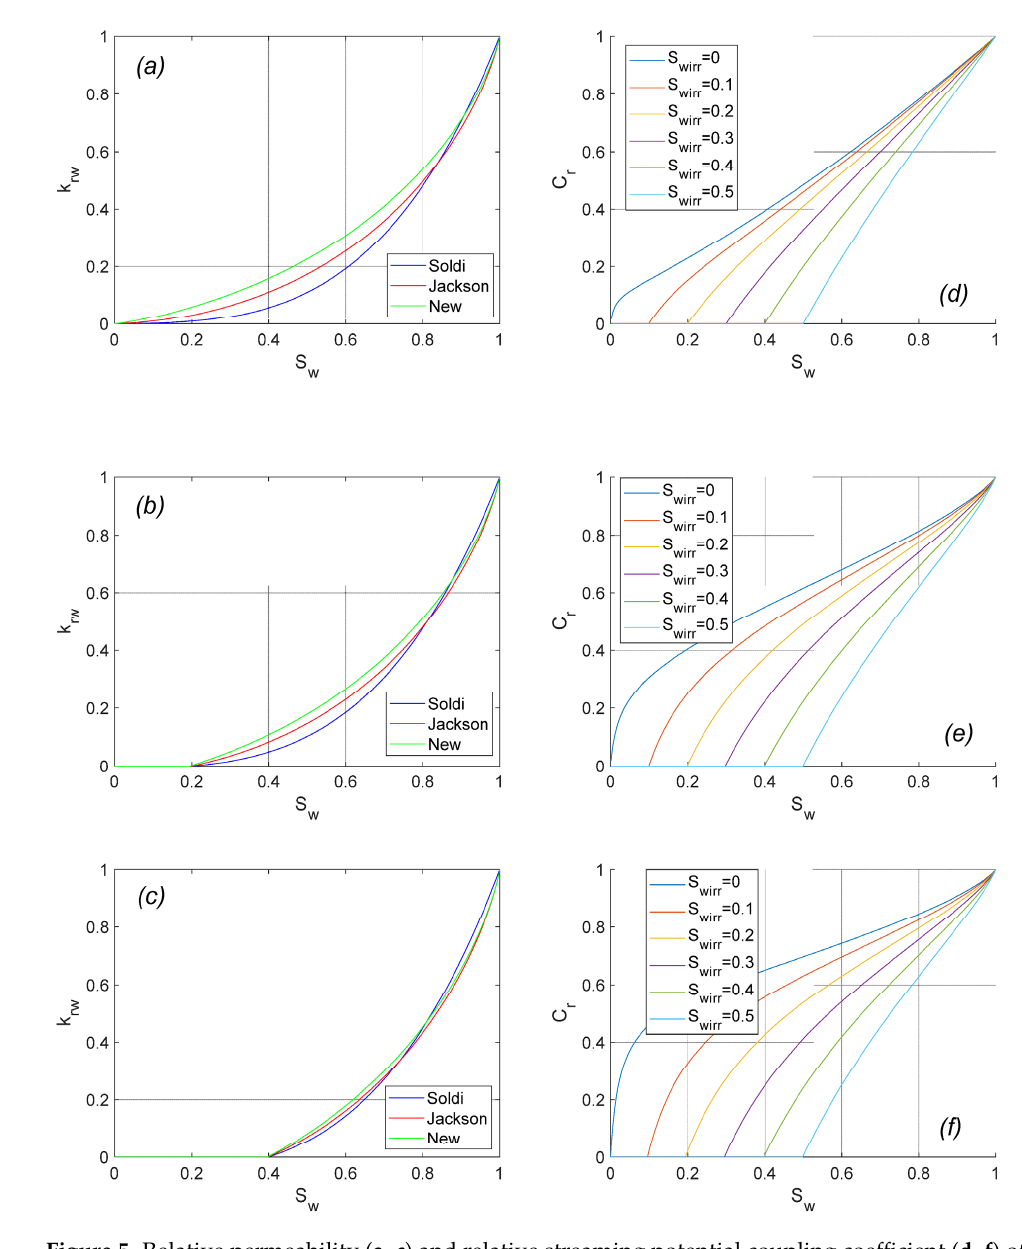
Figure 5. Relative permeability ( a – c ) and relative streaming potential coupling coefficient ( d – f ) of the BOCT model constructed using the Soldi ( a , d ), Jackson ( b , e ) and New ( c , f ) distribution functions with capillaries of alternating radius assuming a thick electrical double layer and significant surface conductivity with maximum capillary radius of 100 μ m.